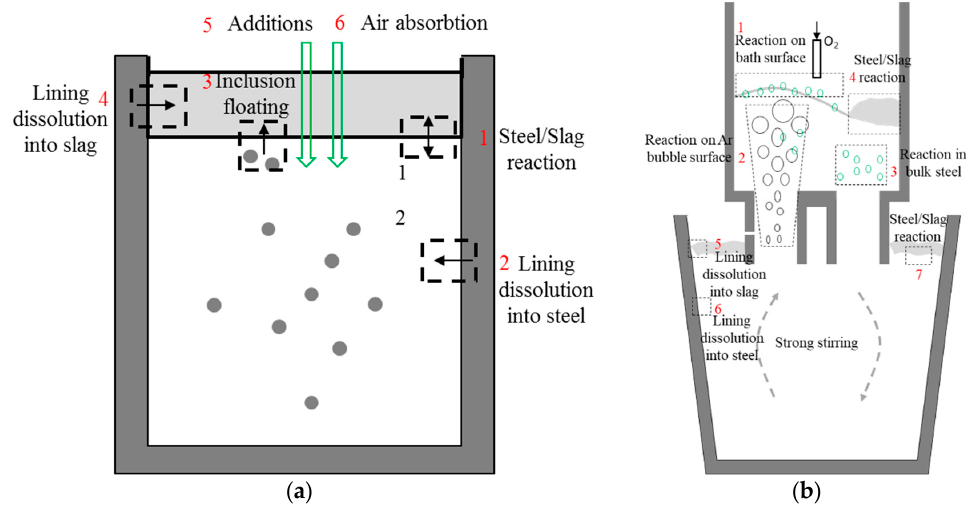
Figure 1. Schematics of the ( a ) LF and ( b ) RH refining.